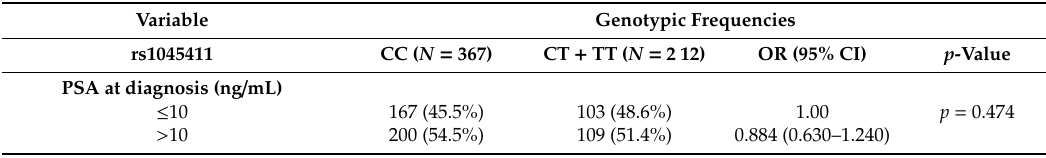
Table 4. Odds ratios (ORs) and 95% confidence intervals (CIs) of clinical status and HMGB1 rs1045411 genotypic frequencies in 579 patients with prostate